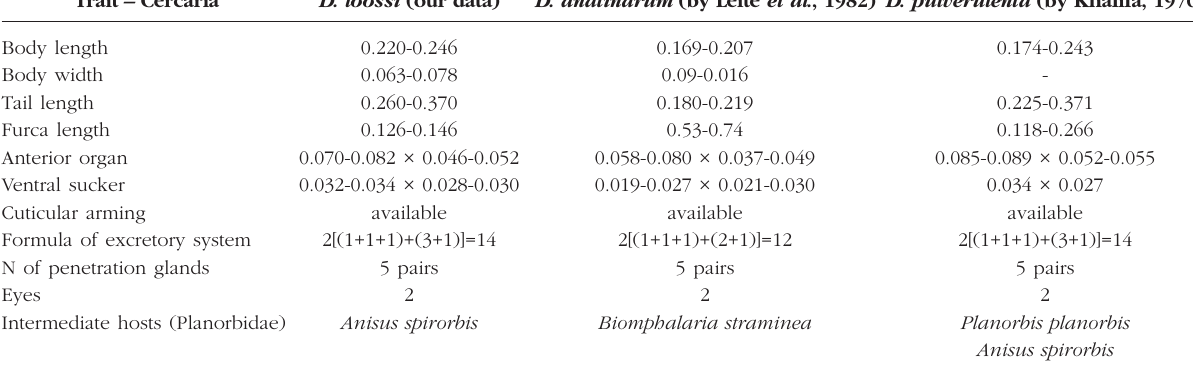
Table VI. – A comparative characteristic of the morphology of cercariae D. loossi , D. anatinarum and D. pulverulenta (sizes in